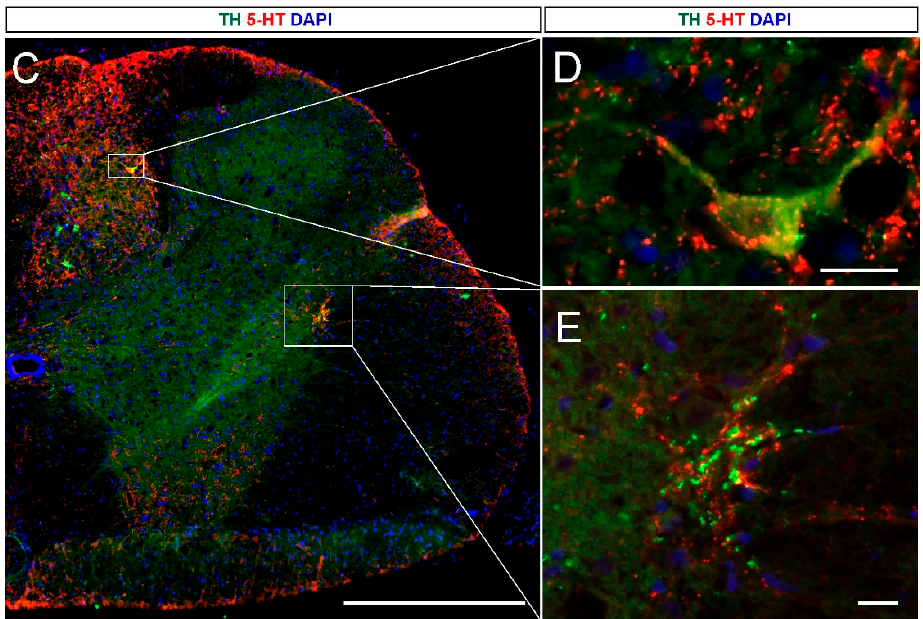
Figure 4. The 5-HT and NA neurons surrounded by each other’s axons identified in the graft vicinity in the host spinal cord of grafted rats. ( A ) an example of the graft area with 5-HT neurons (red) and NA (green) fibers on the cell membrane; ( B ) an example of selected neurons under higher magnification in the confocal image; ( C ) the graft area with 5-HT (red) and NA neurons (green); ( D ) an example of a selected neuron with 5-HT fibers on the cell membrane under higher magnification in the fluorescent image; ( E ) the intermediolateral zone rich 5-HT/NA innervation of graft origin under higher magnification in the fluorescent image. For nucleic acid staining, DAPI was used (blue). Scalebars: 500 µm (A,C); 20 µm (B,D,E). Abbreviations: 5-HT: serotonin; TPH: tryptophan hydroxylase; TH: tyrosine hydroxylase DAPI: 4 ′ ,6-diamidino-2-phenylindole.